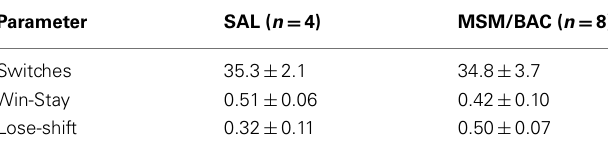
Table 2 | Mean ( ± SEM) values of behavior related parameters for saline-treated and MSM/BAC-treated rats in trial block 61–120 in poor performing animals (trial block